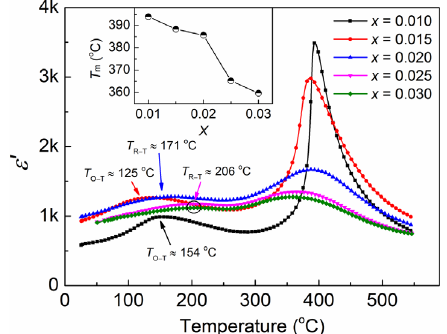
Fig. 4 Temperature dependence of ε ′ for (1 − x )KNN– x BZN ceramics with different BZN contents at 1 MHz. The inset shows T m as a function of BZN content ( x